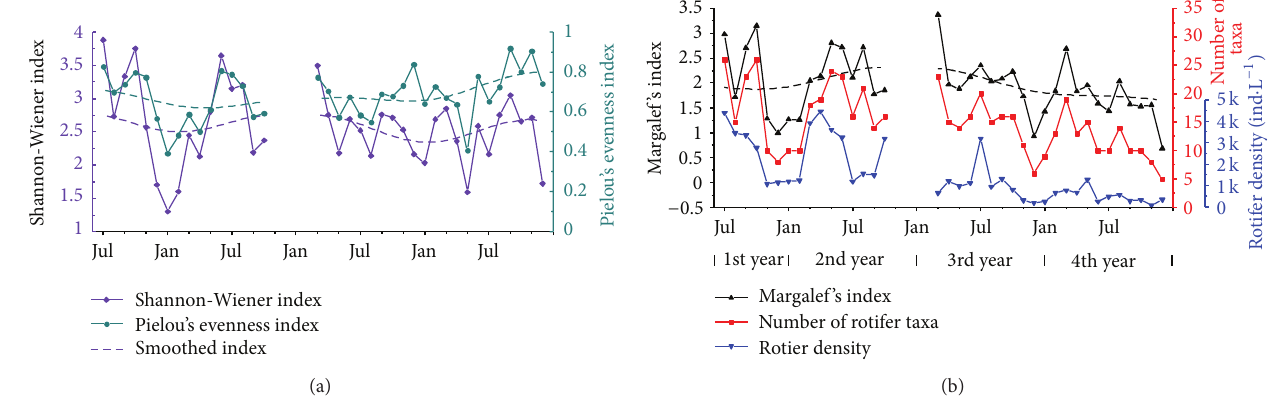
Figure 7: Rotifer diversity indices in Dadian Lake. Smoothed method: FFT filter, six